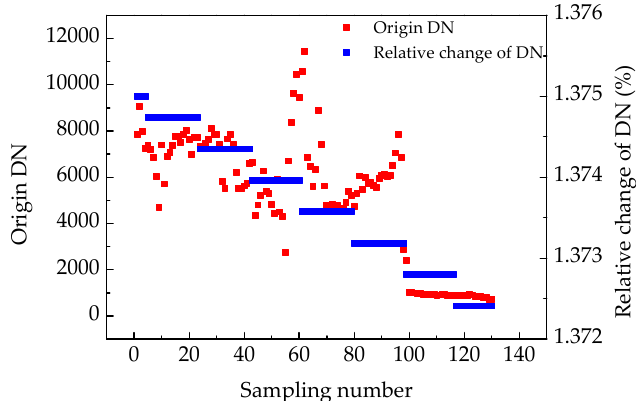
Figure 20. On-orbit application of G(T). The DN values at the nadir of the 2250 nm channel increased Figure 20. On ‐ orbit application of G(T). The DN values at the nadir of the 2250 nm channel in ‐ by approximately 1.37% with G(T) creased by approximately 1.37% with G(T) correction.